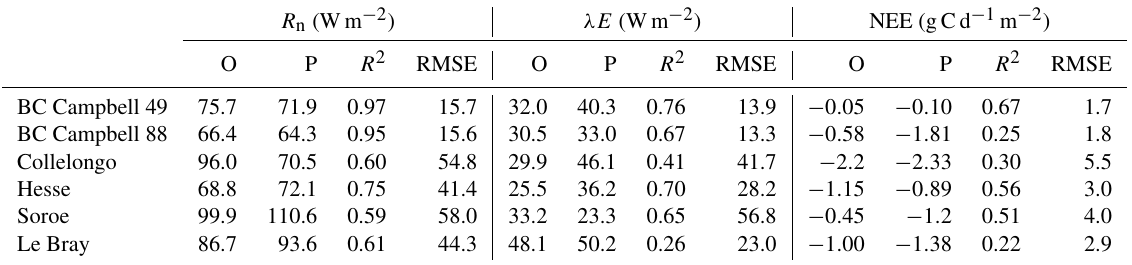
Table 5. Statistics of the model evaluation with daily flux values of net radiation, R n , latent heat flux, λE , and net ecosystem exchange, NEE, at six sites: R 2 and RMSE. The daily average of the observed (O) and predicted values (P) are given.